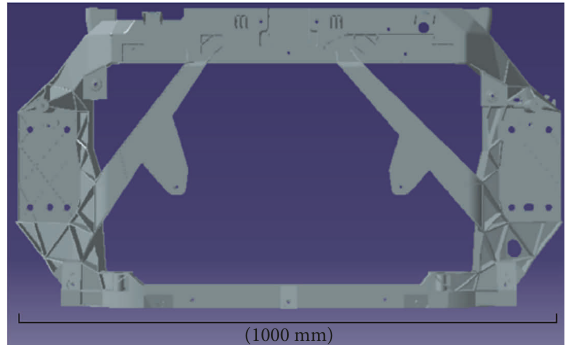
Figure 1: Automobile front-end frame model diagram.